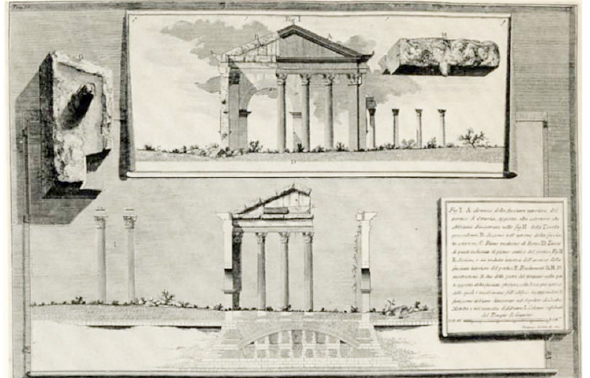
Figure 1- Piranesi, interior facade Ottavia colonnade. Facade sections